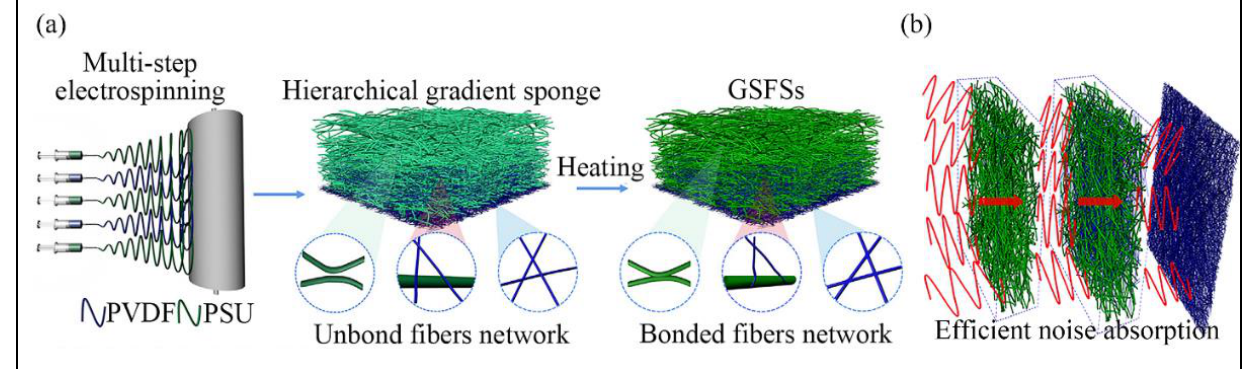
Figure 5. Fabrication of GSFSs ( a ) Fabrication process of GSFSs; ( b ) Sound absorption process of GSFSs. Reprinted with permission from ref. [85]. Copyright 2021 Elsevier.